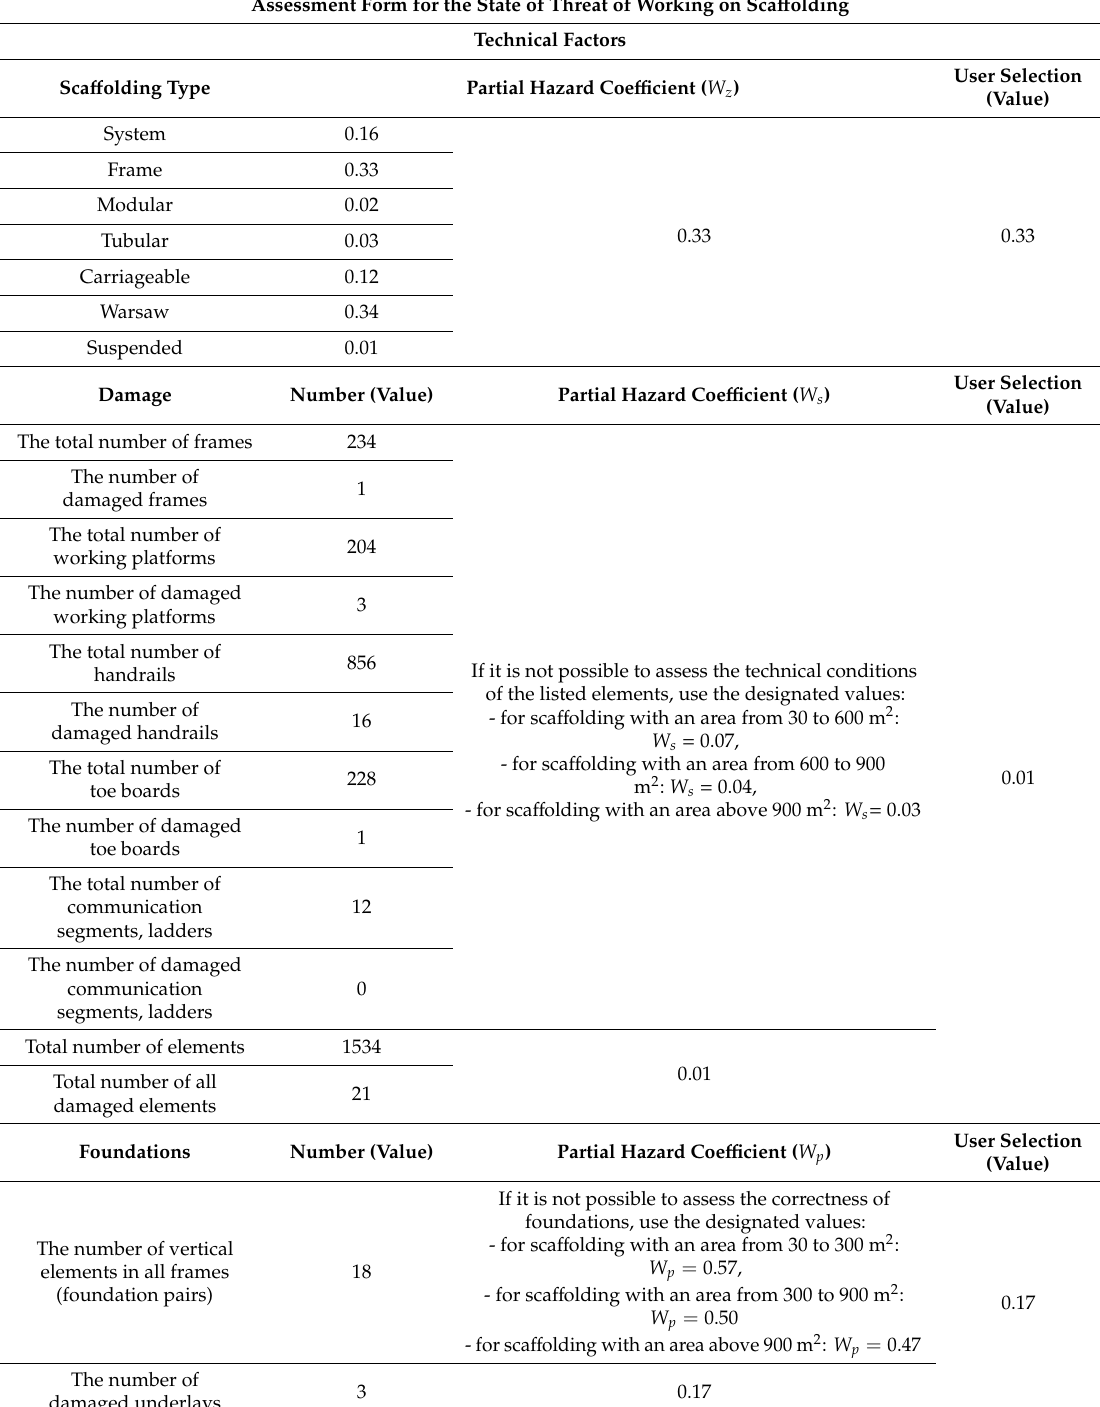
Table 11. Assessment form for the state of threat of working on sca ff olding—case study. Assessment Form for the State of Threat of Working on Sca ff